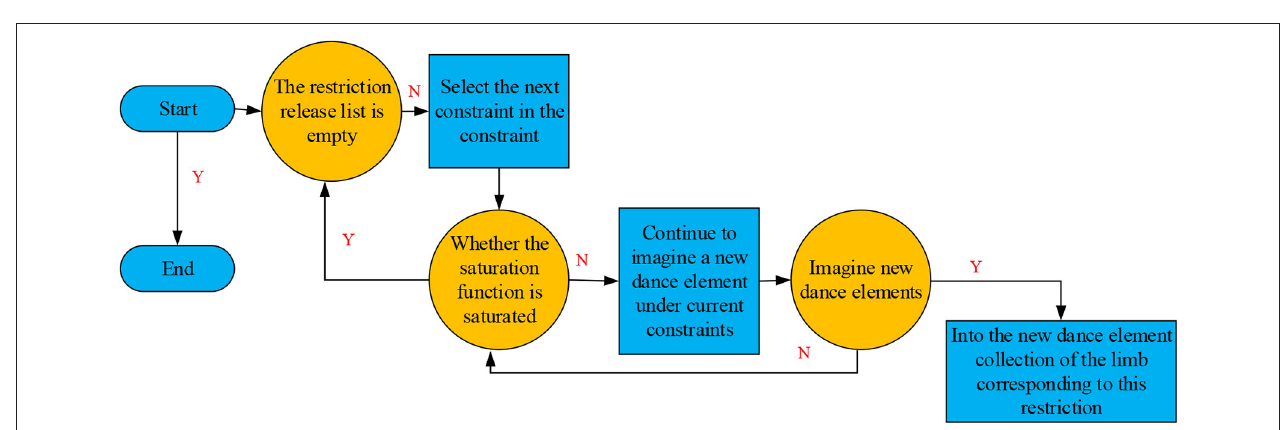
FIGURE 6 | Algorithm flow of imagining new dance elements using the release-constrained